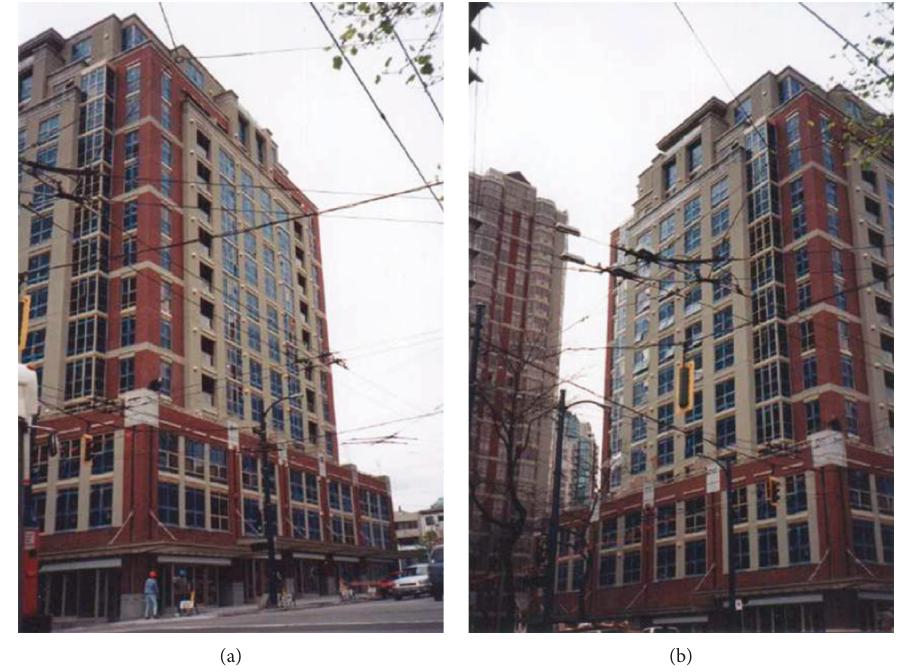
Figure 3: North (a) and east (b) building faces of the Heritage Court Tower in Vancouver,